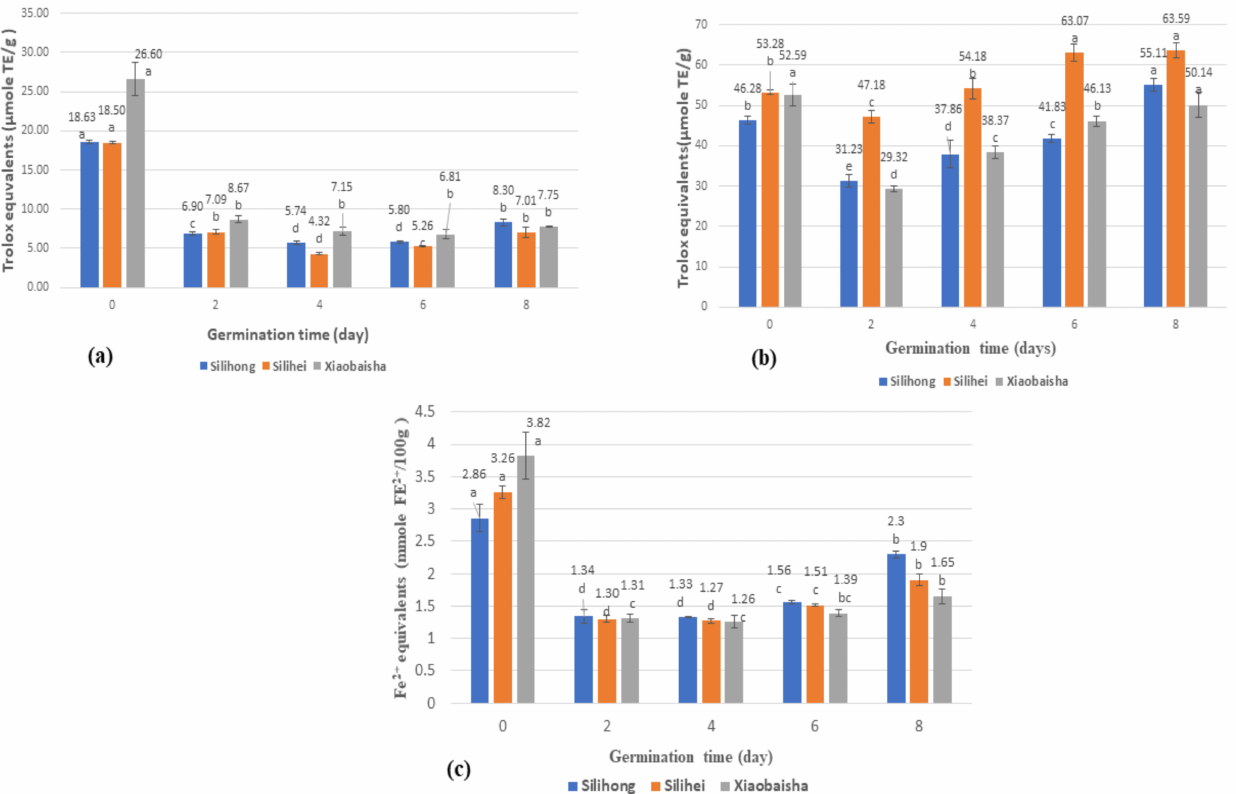
Figure 4. Kinetic changes of ( a ) DPPH free radical scavenging activity, ( b ) ABTS radical scavenging activity, ( c ) ferric reducing antioxidant capacity (FRAP) of peanut during germination. Data marked with the same letters were not statistically significant ( p >